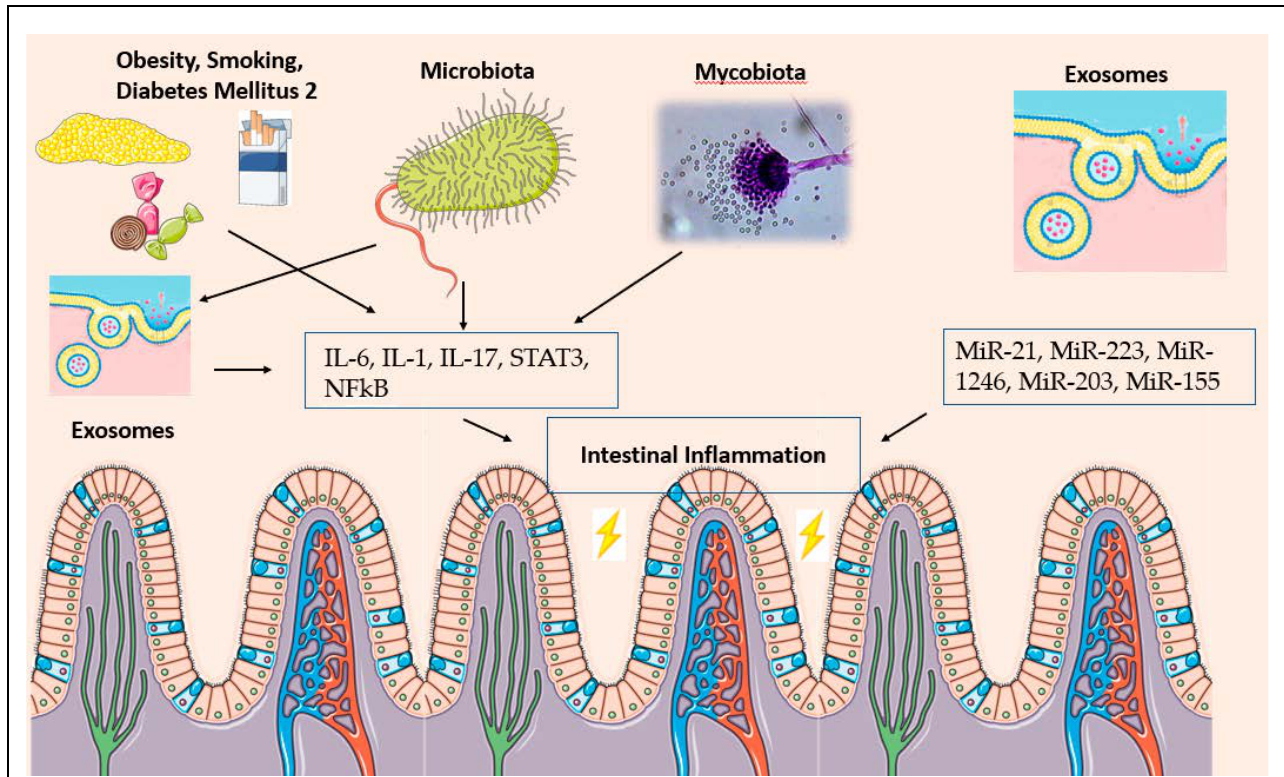
Figure 6. Crosslinks between obesity, cigarette smoking, diabetes mellitus tye 2, microbiota, mycobiota, and exosomes and their collective impact on creating intestinal inflammation.